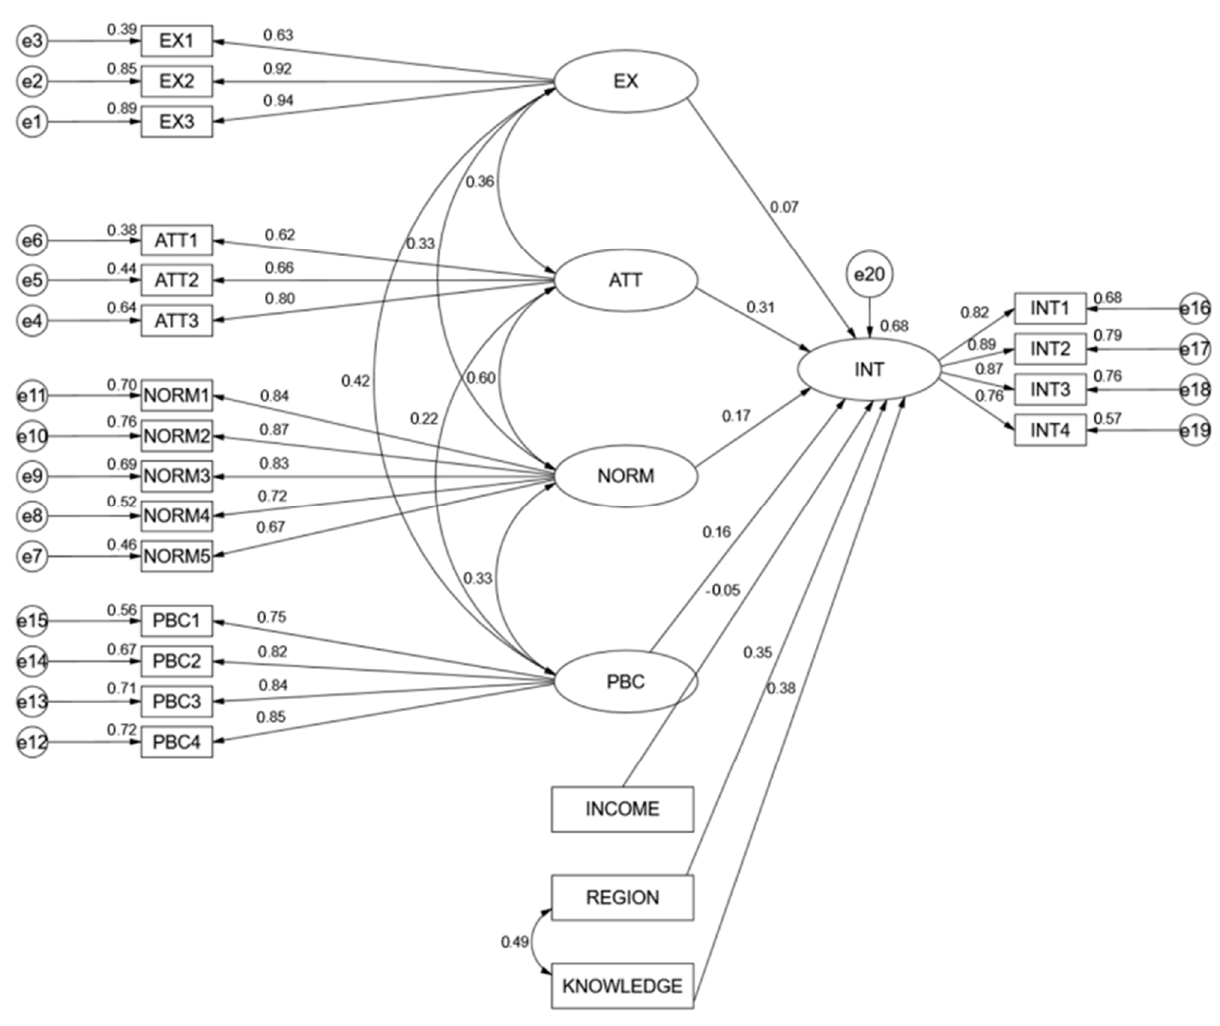
Figure 3. The model and standardized path coefficients. Table 6. Estimation results and hypothesis